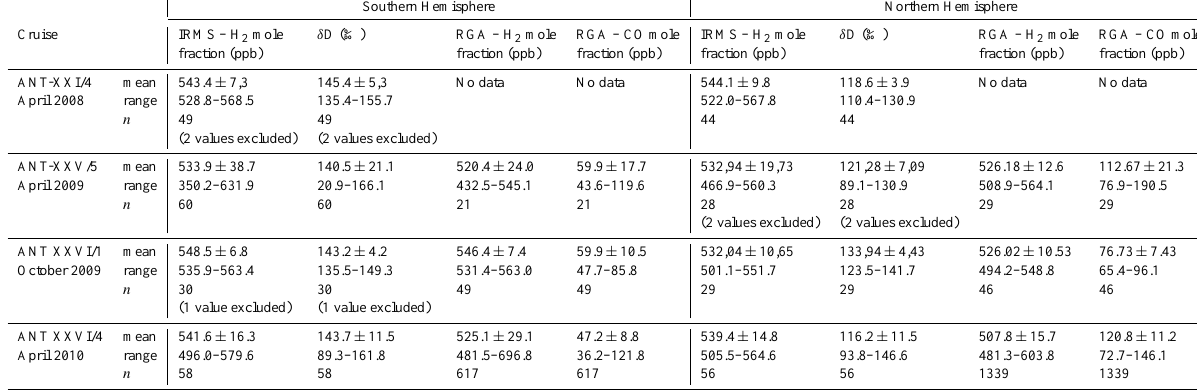
Table 2. Hemispheric means of atmospheric H 2 and its isotopic composition along the four meridional Atlantic transects. Southern Hemisphere Northern